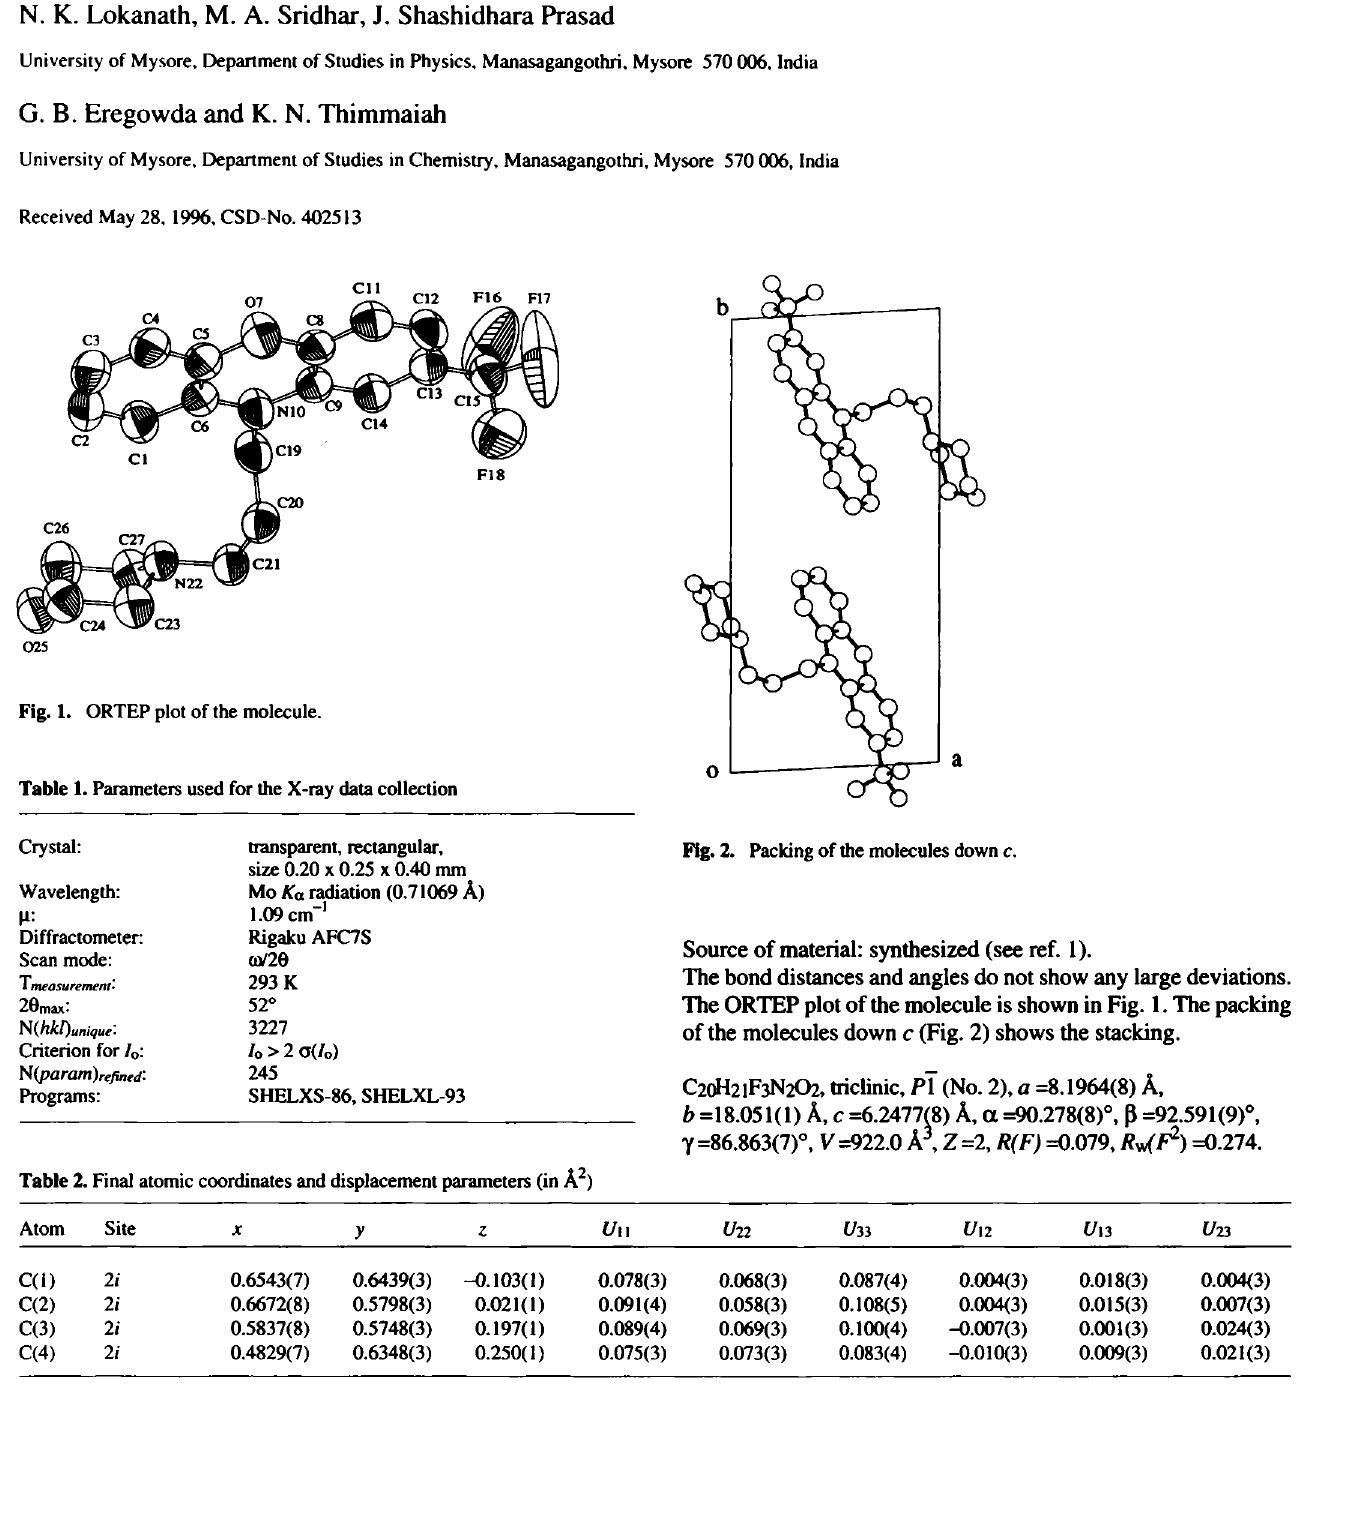
Fig. 2. Packing of the molecules down c.